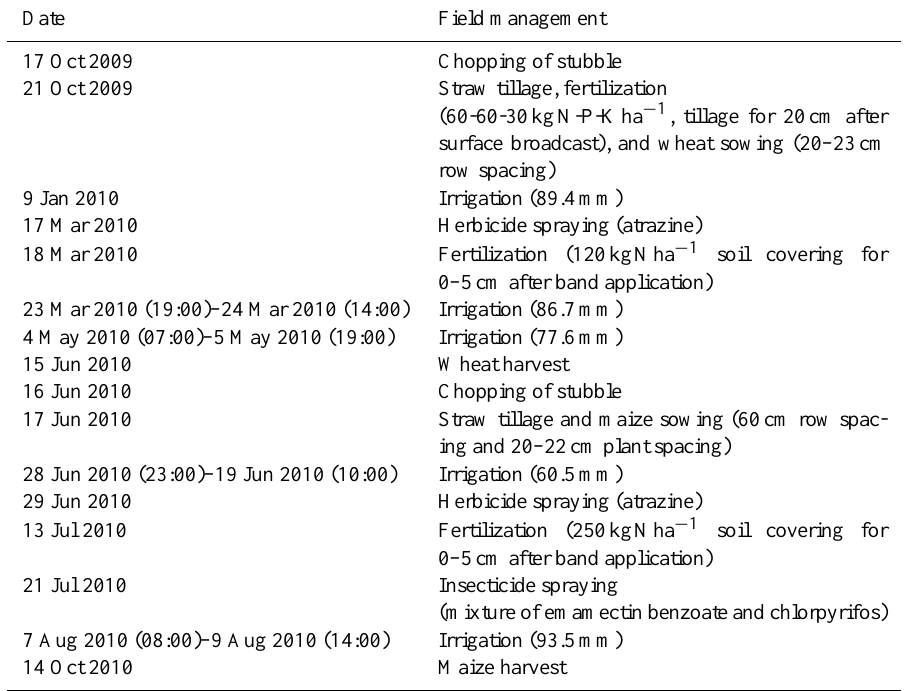
Table 1. Information regarding main field